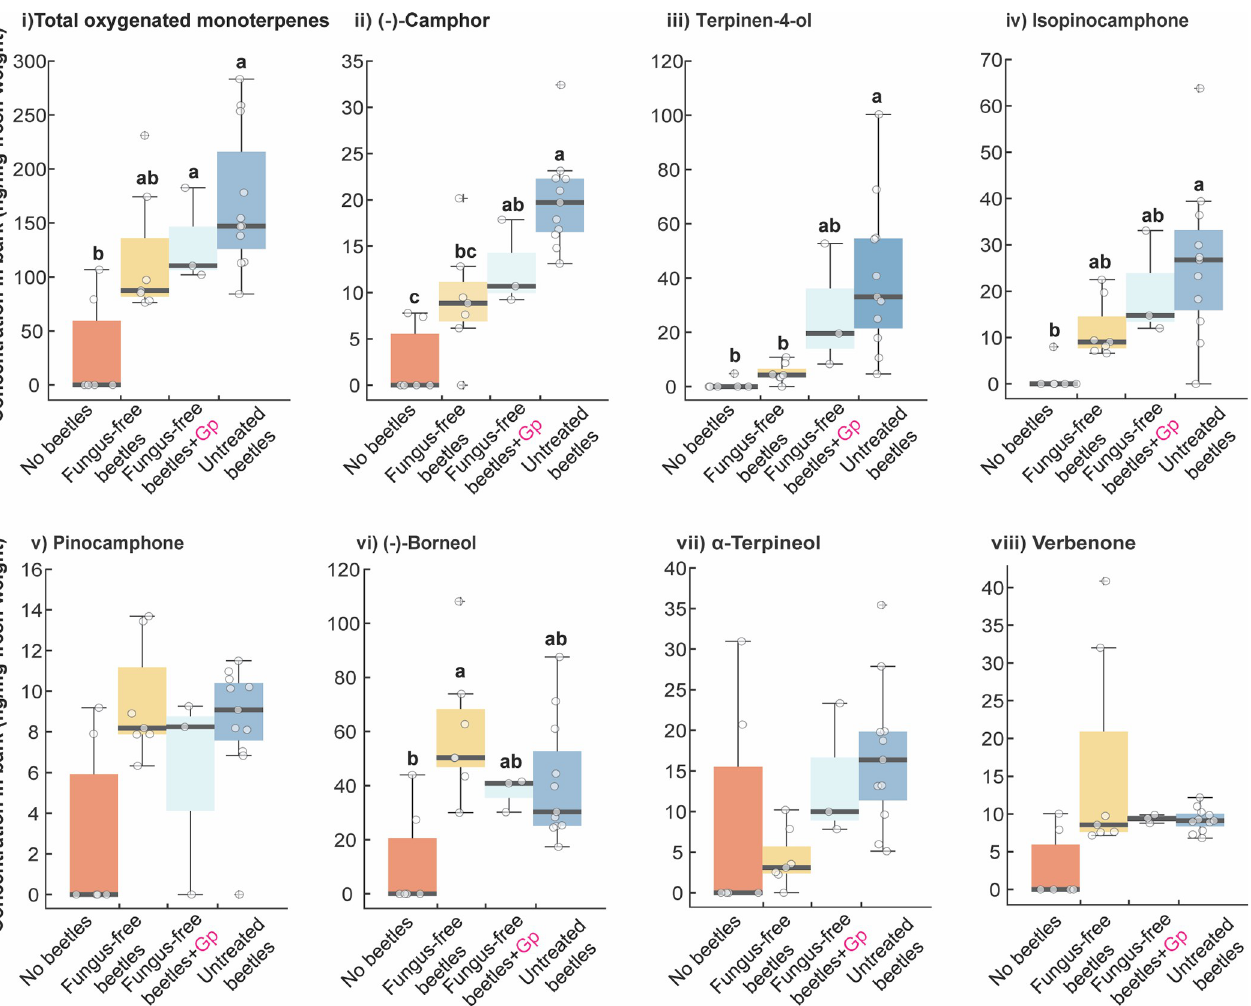
Fig 4. Oxygenated monoterpenes identified in I . typographus -infested spruce bark are produced by fungi associated with bark beetles. Concentration of total oxygenated monoterpenes (i), camphor (ii), terpinen-4-ol (iii), isopinocamphone (iv), pinocamphone (v), borneol (vi), α -terpineol (vii), and verbenone (viii) in bark without beetles, infested with fungus-free beetles, infested with fungus-free beetles reinoculated with G . penicillata , and untreated beetles. Different lowercase letters indicate significant differences between treatments (ANOVA, Tukey’s test, P < 0.05). The data underlying this Figure can be found at